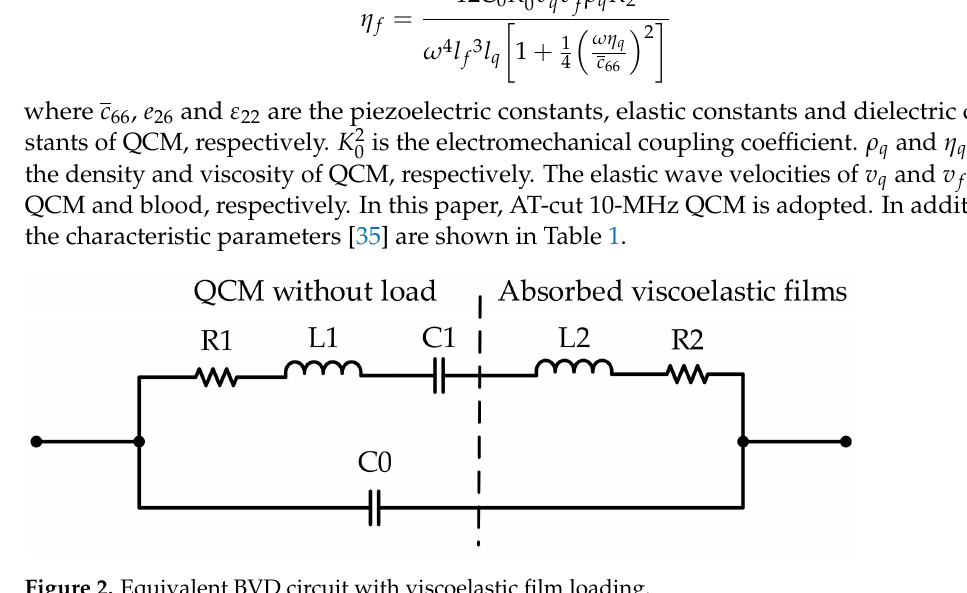
Figure 2. Equivalent BVD circuit with viscoelastic film loading. Table 1. Characteristic Parameters of QCM.